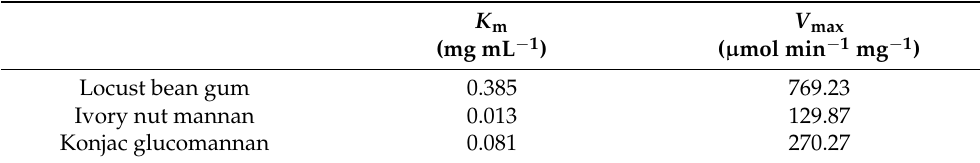
Table 3. The kinetic parameters of ManNj6-379 on mannan